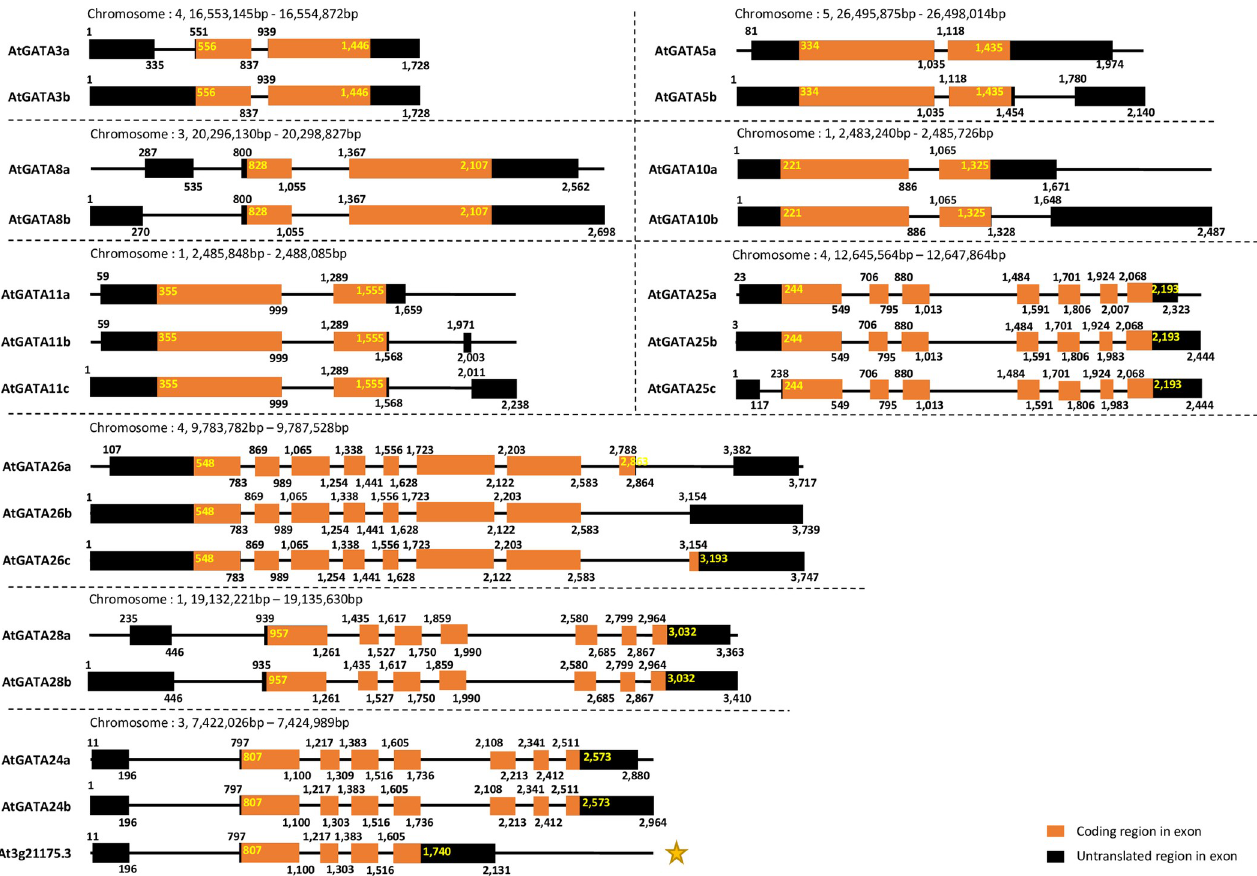
Fig 3. Gene structure of alternative splicing forms of GATA genes in A . thaliana Col0. It shows alternative splicing forms of GATA genes in A . thaliana Col0. Black and orange color thick boxes indicate exons and lines means intron. Black- or orange-colored boxes indicate untranslated and coding regions in exons, respectively. Numbers around exon boxes present relative base pair position started from a transcript start position of each gene. Yellow star indicates one of the alternative splicing forms of GATA gene without GATA domain.